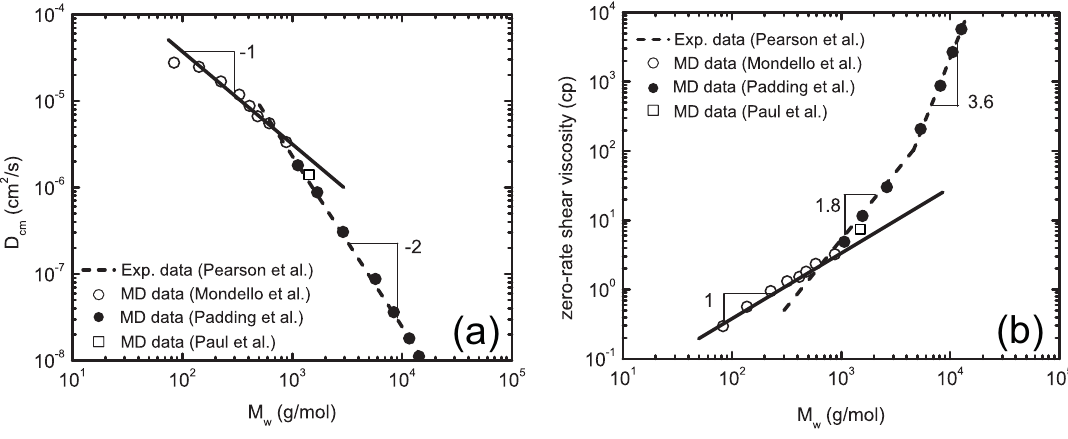
, and ( b ) zero-rate shear viscosity, η cm